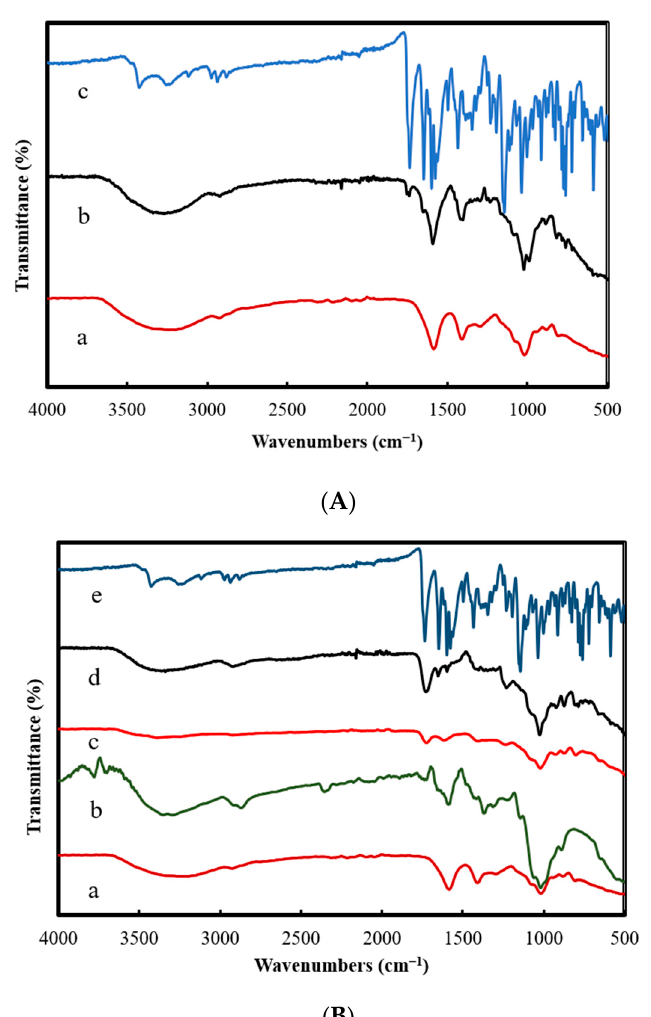
Figure 1. ( A ) IR spectra of Ca-Alg